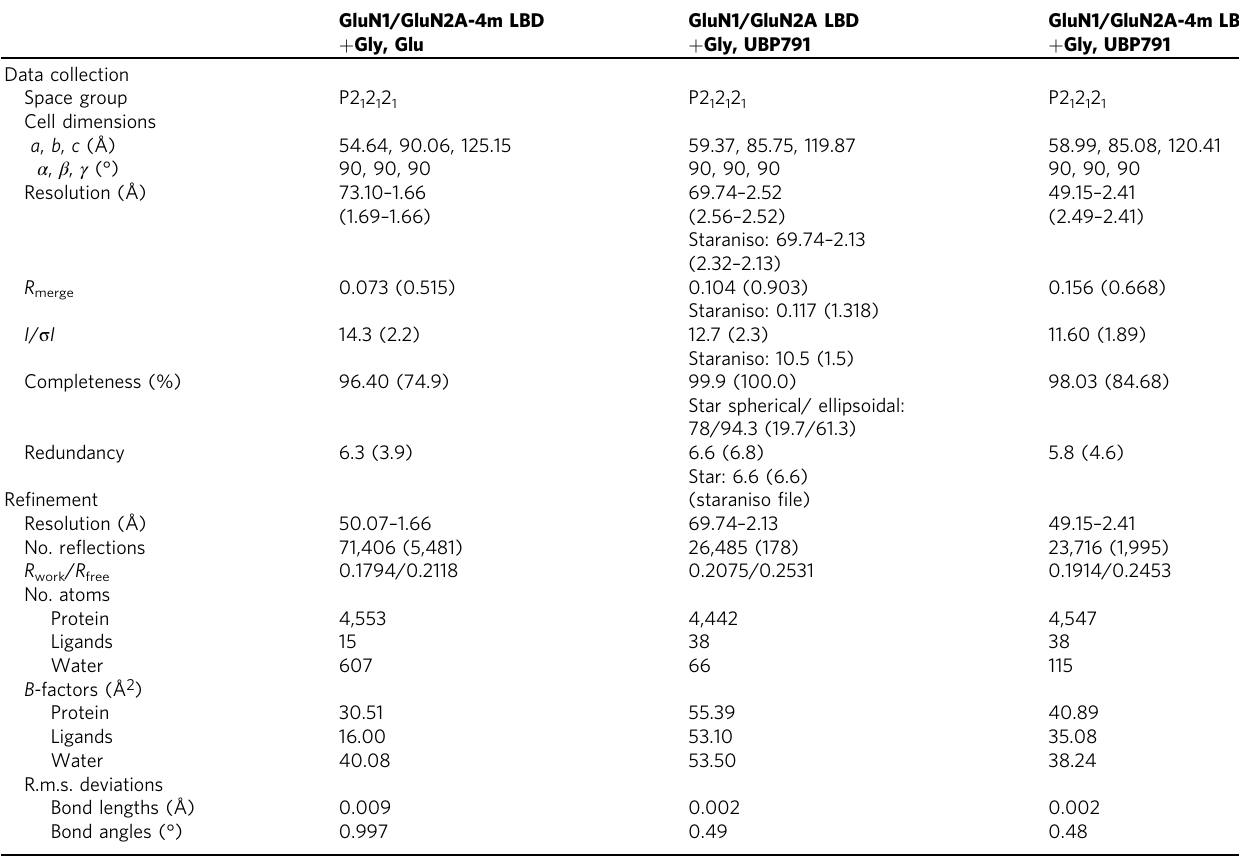
Table 1 Data collection and re fi nement statistics (molecular